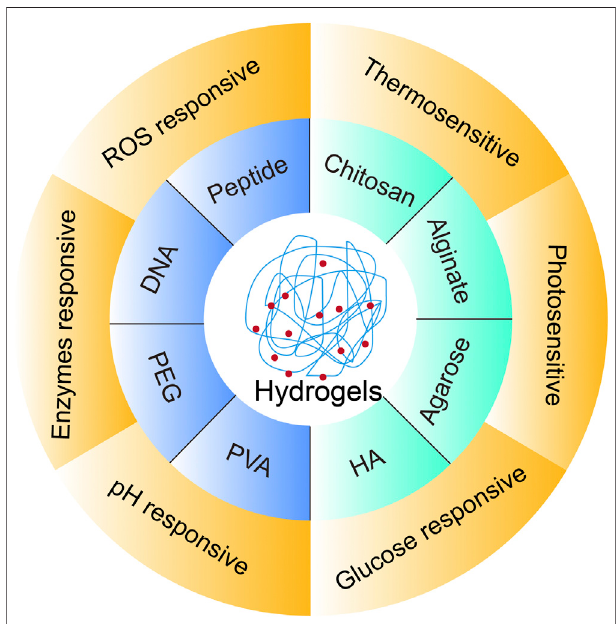
FIGURE 1 | Schematic diagrams showing the rational design of smart